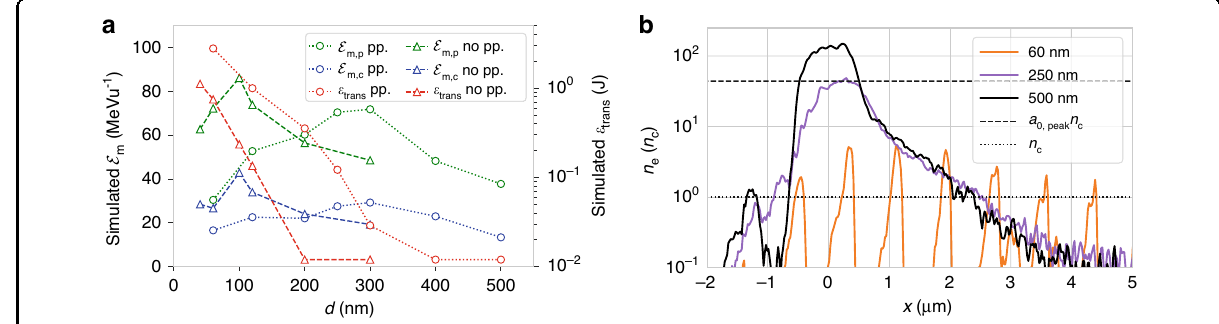
Fig. 3 Modelling target pre-expansion. a Comparison of simulations including laser prepulse (dotted/circles) and simulations without prepulse starting 50 fs before the peak of the pulse (dashed/triangles), showing maximum carbon and proton energies E m and transmitted laser energy Ɛ trans as a function of target thickness d . b Electron density lineouts 35 fs before the arrival of the peak of pulse for different target thicknesses. For d = 60 nm, the target is already transparent, resulting in electron